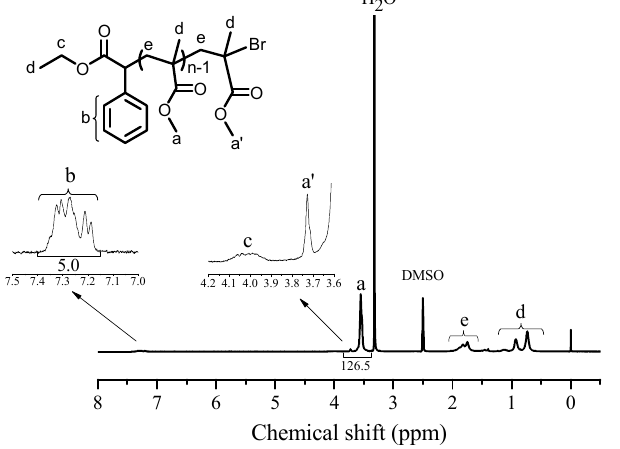
Figure 3. 1 H NMR spectrum of PMMA ( M n,GPC = 4200 g · mol –1 , M n,NMR = 4300 g · mol –1 , M w / M n = 1.12) obtained from AGET ATRP using thiol-functional cell paper as reducing agent with DMSO as the solvent and tetramethyl silane (TMS) as an internal standard. Polymerization conditions: [MMA] 0 /[EBPA] 0 /[CuBr 2 ] 0 /[PMDETA] 0 = 400/4/0.25/0.5, m (Cell-SH) = 50 mg, V MMA = 2.0 mL, V anisole = 1.0 mL, Temperature = 90 °C, time = 1.5 h.